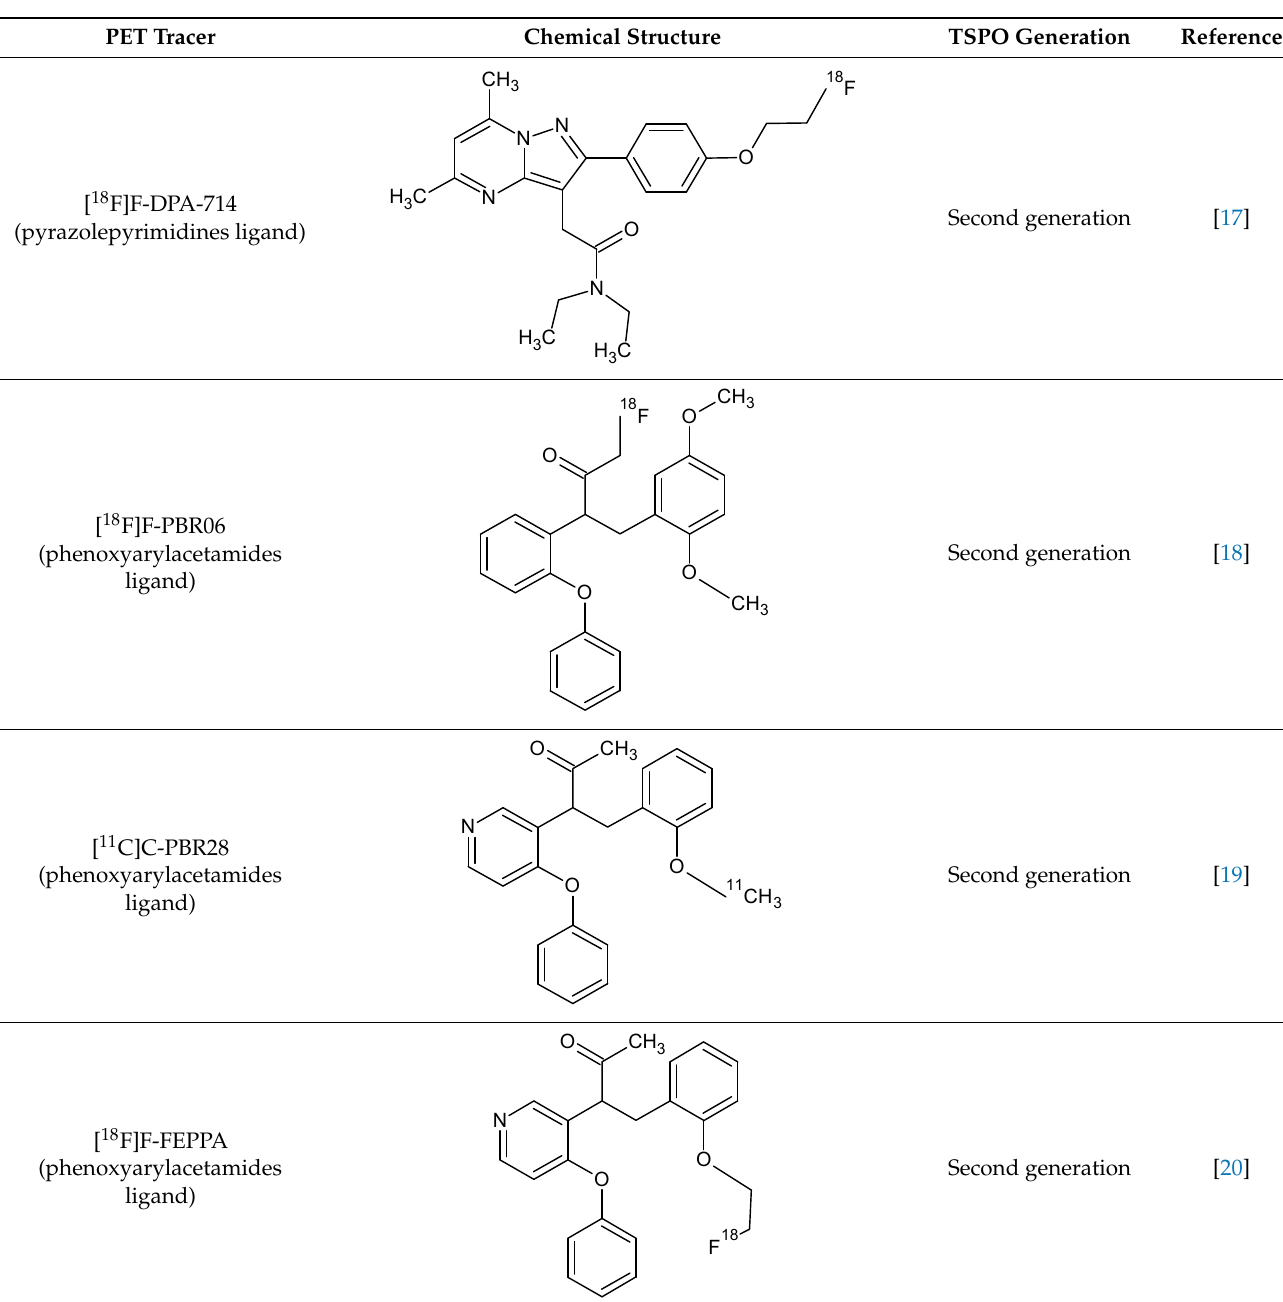
Second generation